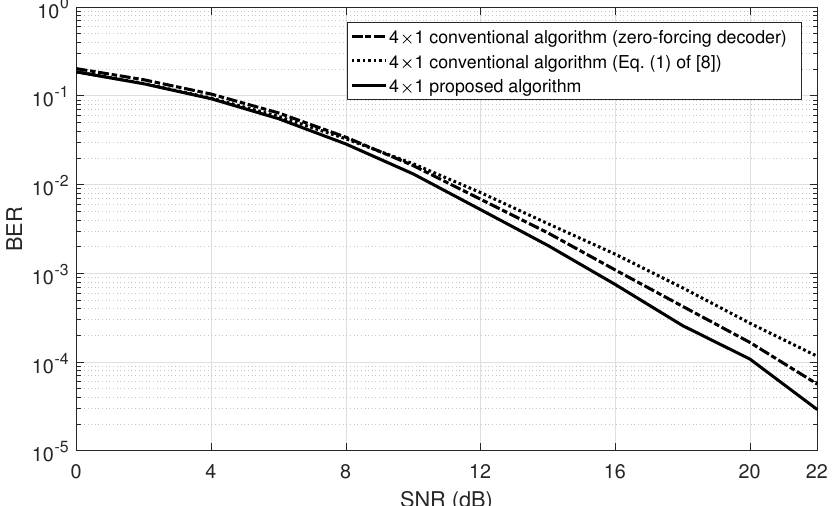
Figure 2. Bit-error-rate (BER) performance of the conventional quasi-orthogonal space–time block code (QO-STBC) and proposed algorithm as a function of the signal-to-noise ratio (SNR) for the four antennas system in a Rayleigh fading